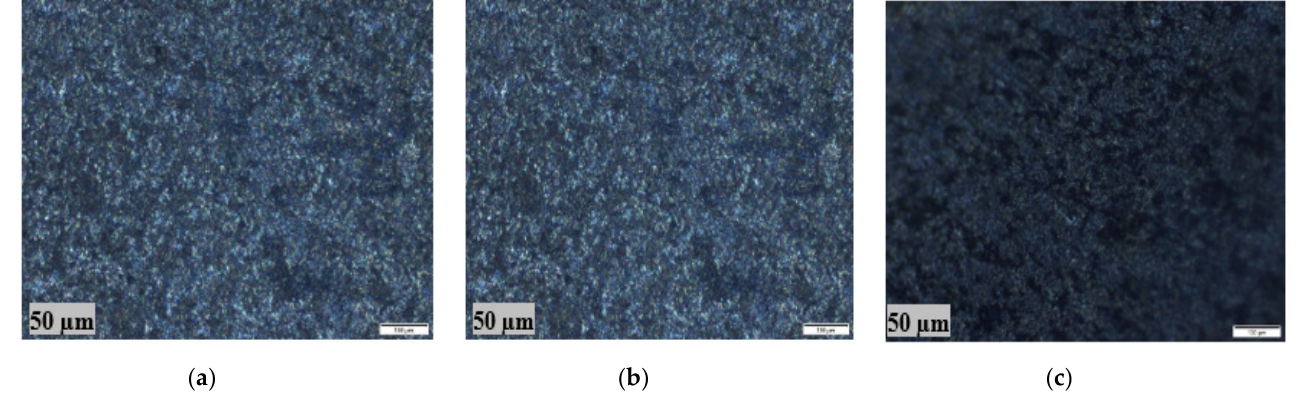
at La(acac) (cid:5) 3 La(acac) (cid:5)